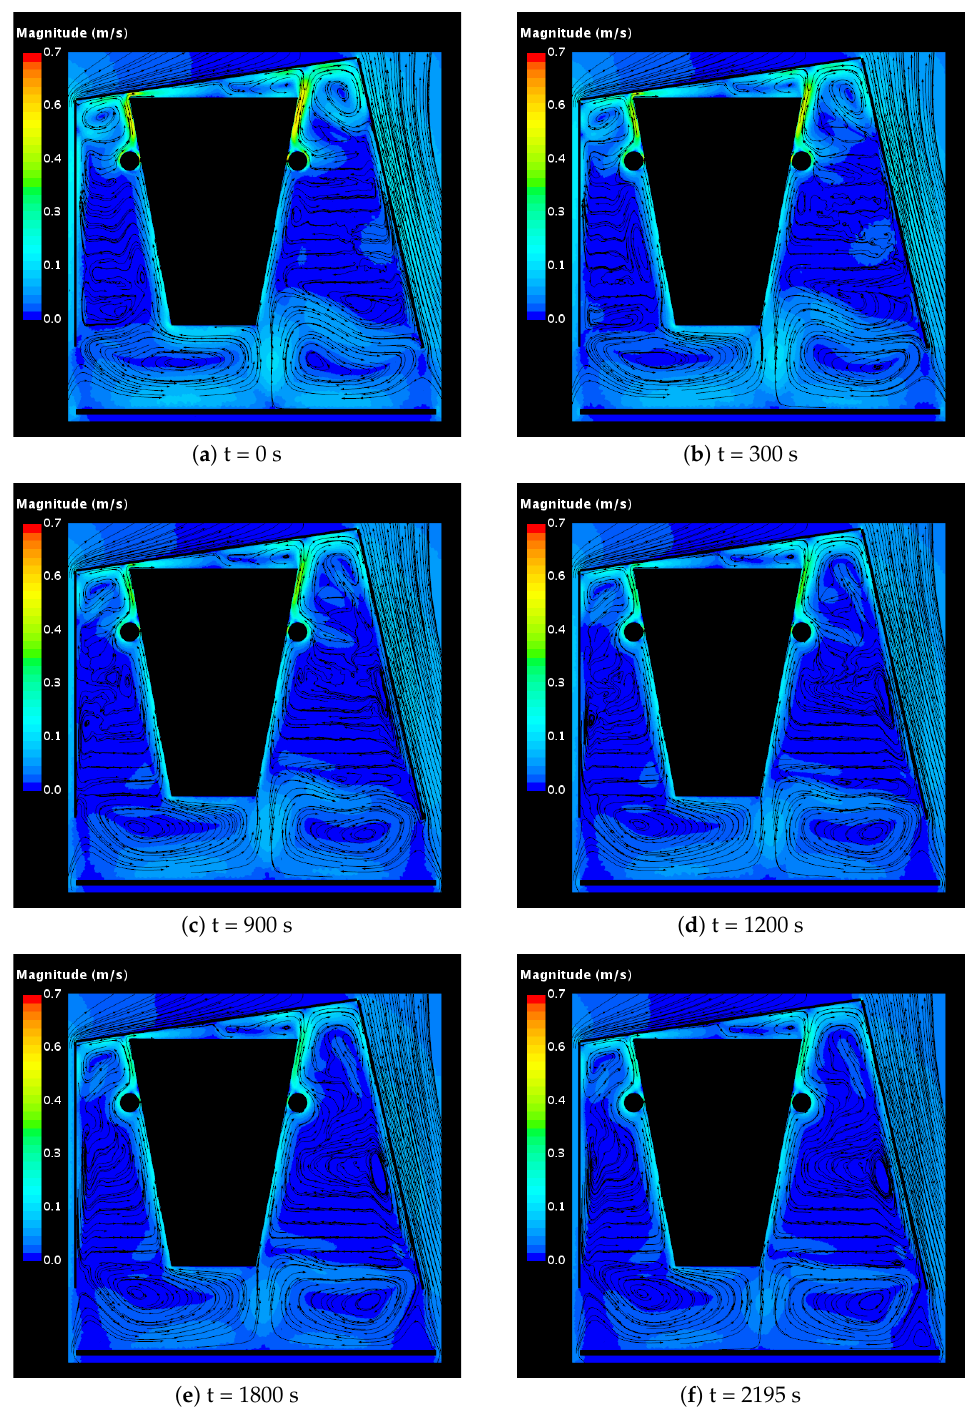
Figure 10. Simulation results for the velocity field in the central section